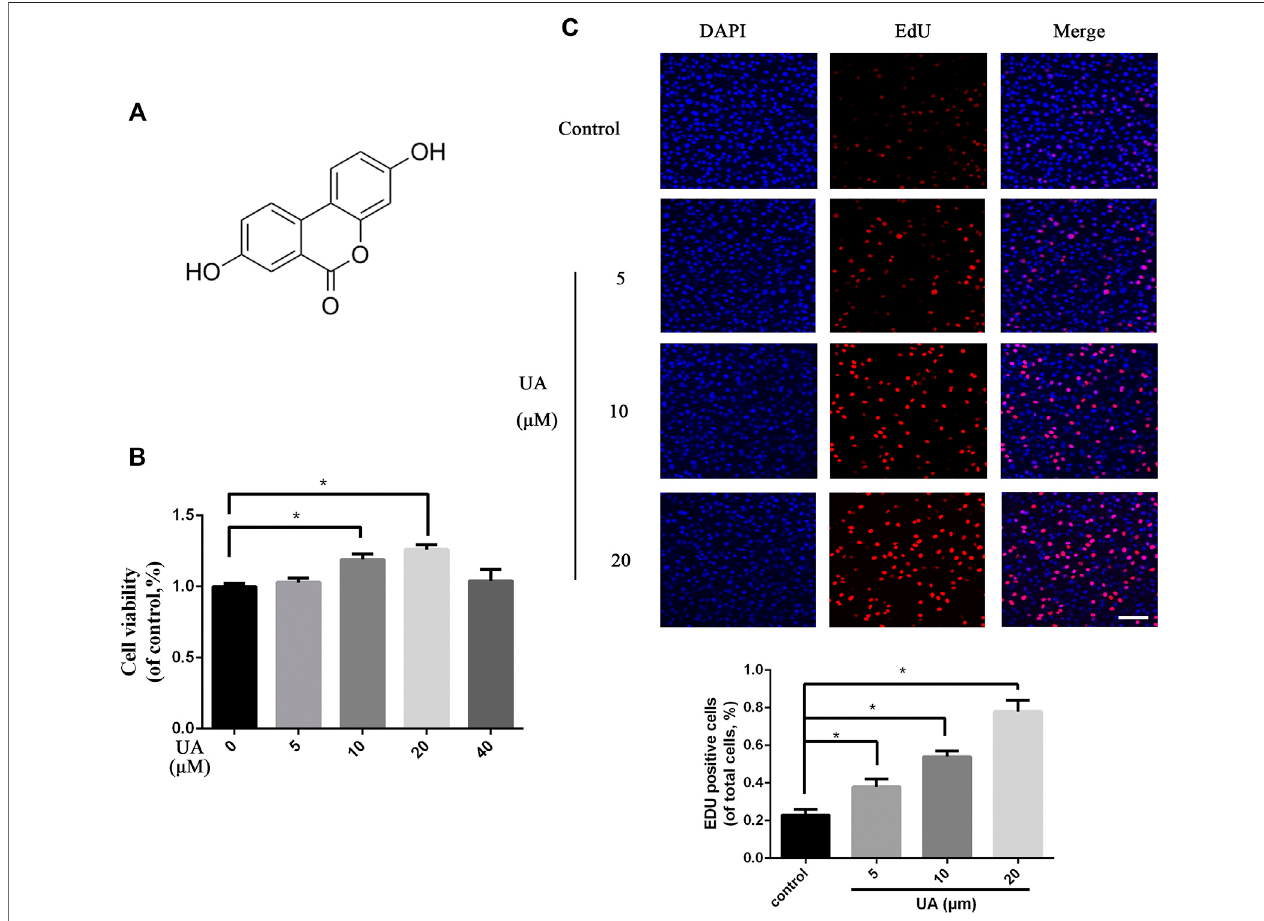
FIGURE 1 | Effect of UA on cellular proliferation of HUVECs. (A) Chemical structure of UA. (B) Cell viability test results of HUVECs treated with different concentrationsofUA. (C) EdUcellproliferationtestresultsofHUVECstreatedwithdifferentdosesofUA(scalebar=100 μ m).StatisticsoftheEDUexperiment.Thedata represent mean ± SD ( n = 3) (* p <